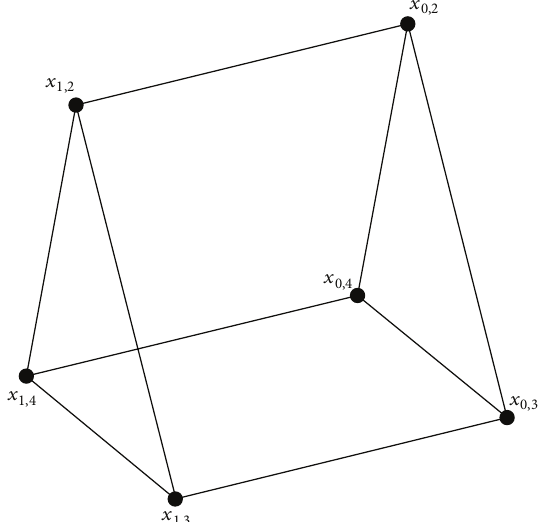
complete graphs are joined to each other